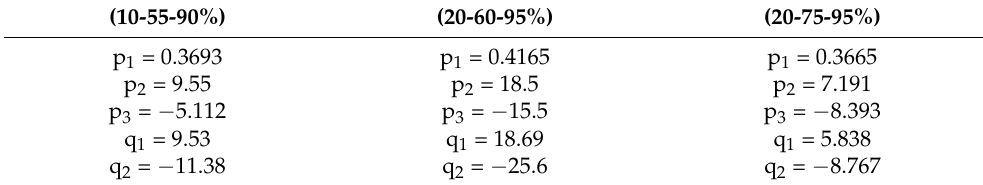
Table 7. Parameters {p i , q i } of the rational function f 1 ( ∆ ) for the different sets of asymmetrical points.